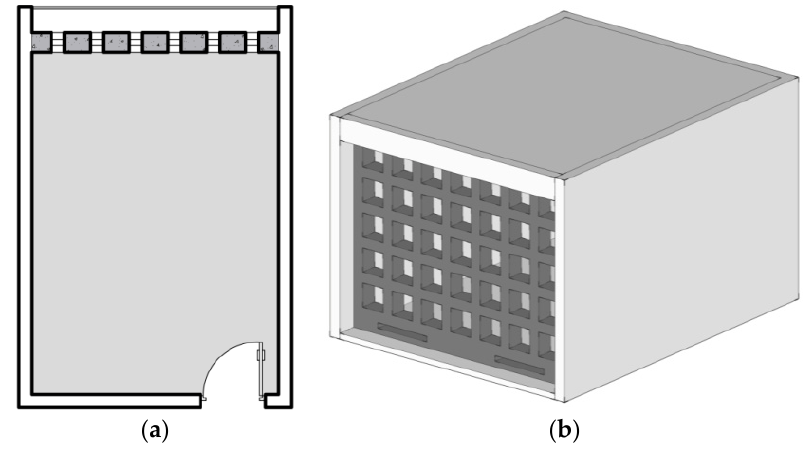
Figure 1. Diagrammatic rendering of perforated mass shading: ( a ) The plan; ( b ) The axonometric